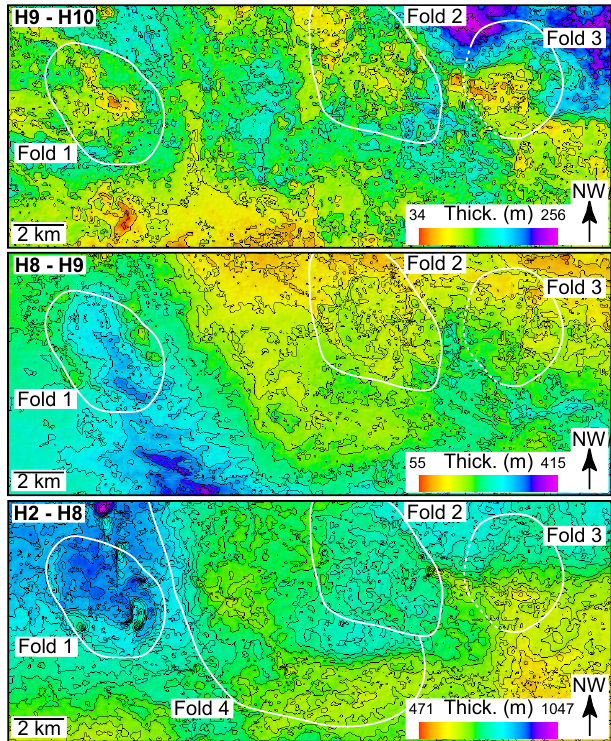
Figure 9: Thickness (Thick.) maps for intervals H2–H8, H8–H9, and